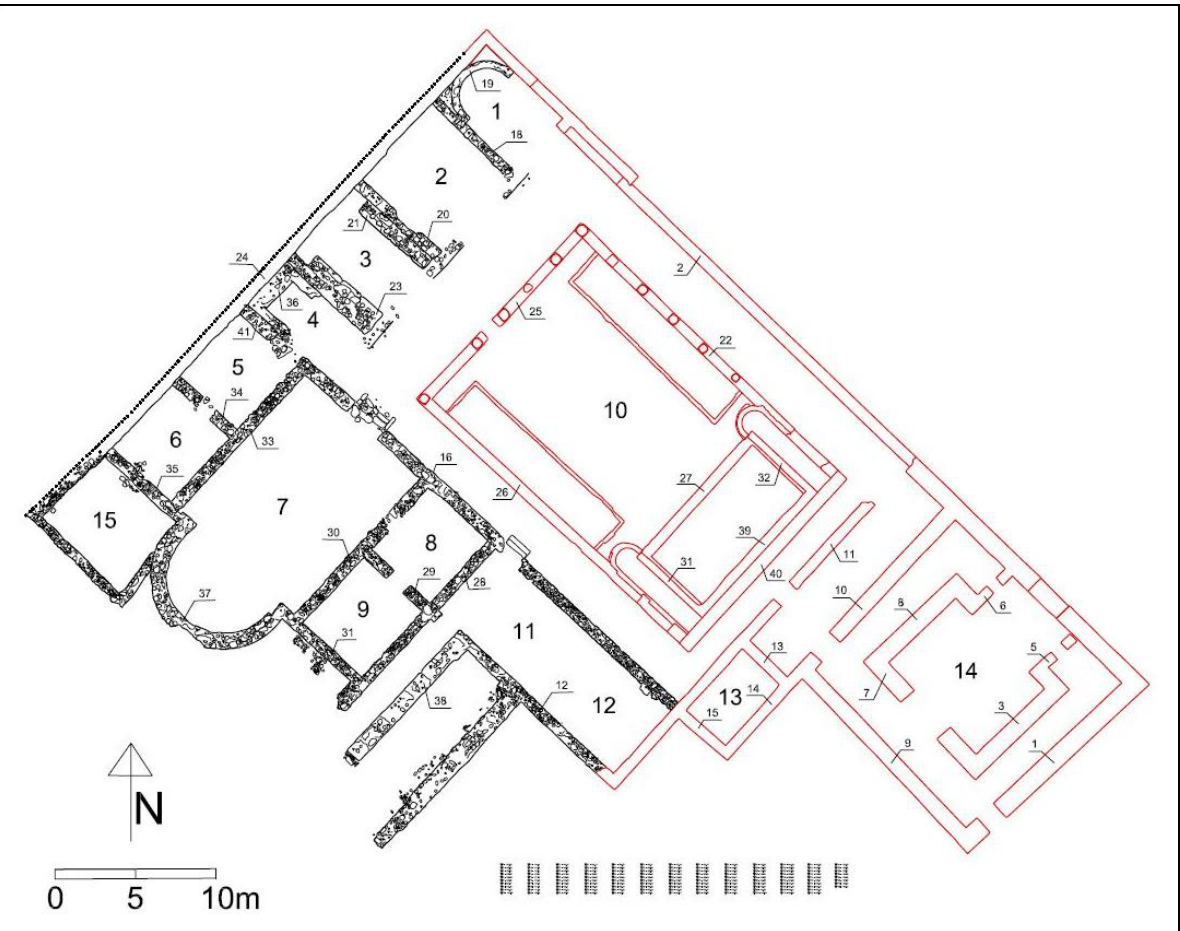
Figure 10. Complete Top Plan